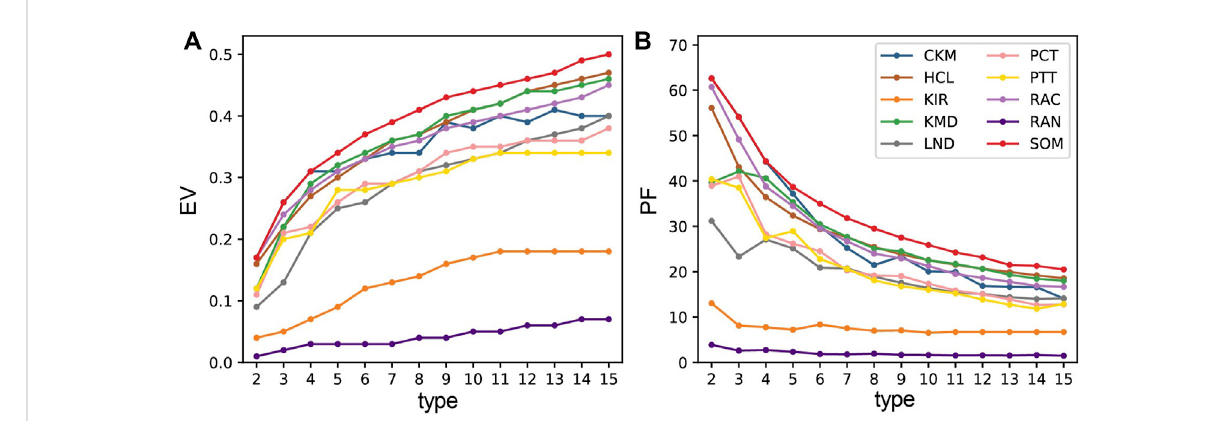
FIGURE 2 Evaluation results of different objective classi fi cation methods by line charts. (A) EV; (B)